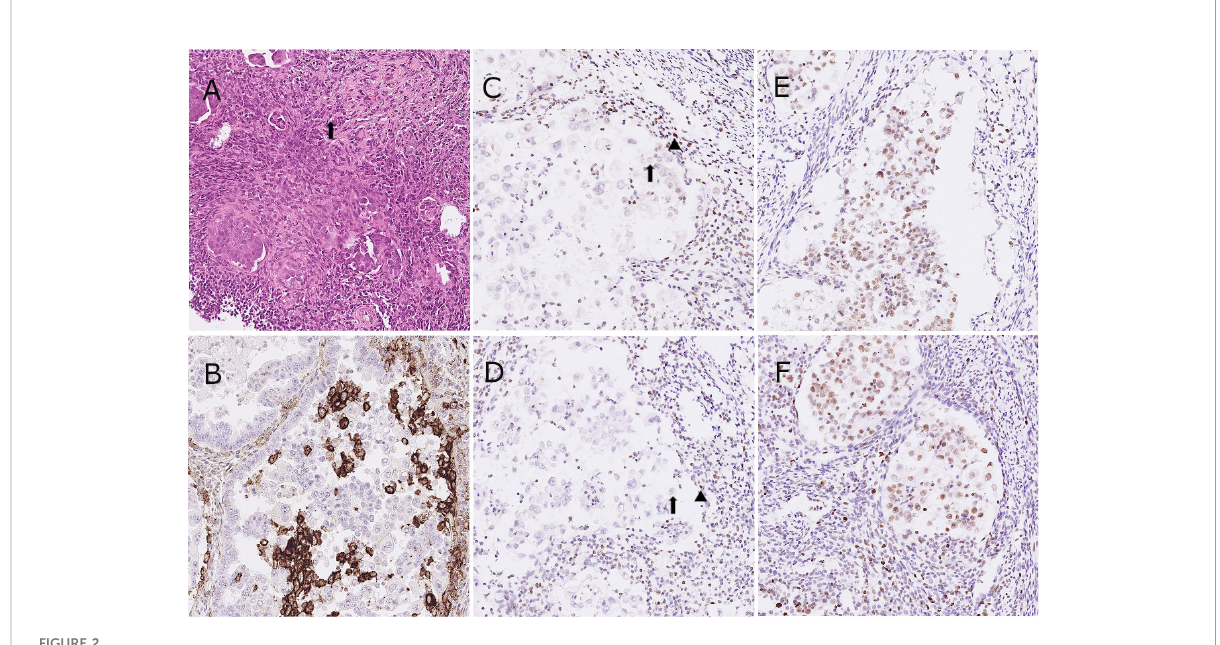
FIGURE 2 Representative images of hematoxylin and eosin stain (A) , tumor cells with a hobnail shape and abundant clear cytoplasm (arrow); immunohistochemistry for PD-L1 (B) and four MMR proteins as MLH-1, PMS-2, MSH-2 and MSH-6 in the patient. (C-F) , tumor cells with equivocal loss of MLH-1 [arrow, (C) ], stromal cells for positive control [arrowhead, (C) ]; tumor cells with complete loss of PMS-2 [arrow, (D) ], stromal cells for positive control [arrowhead, (D)